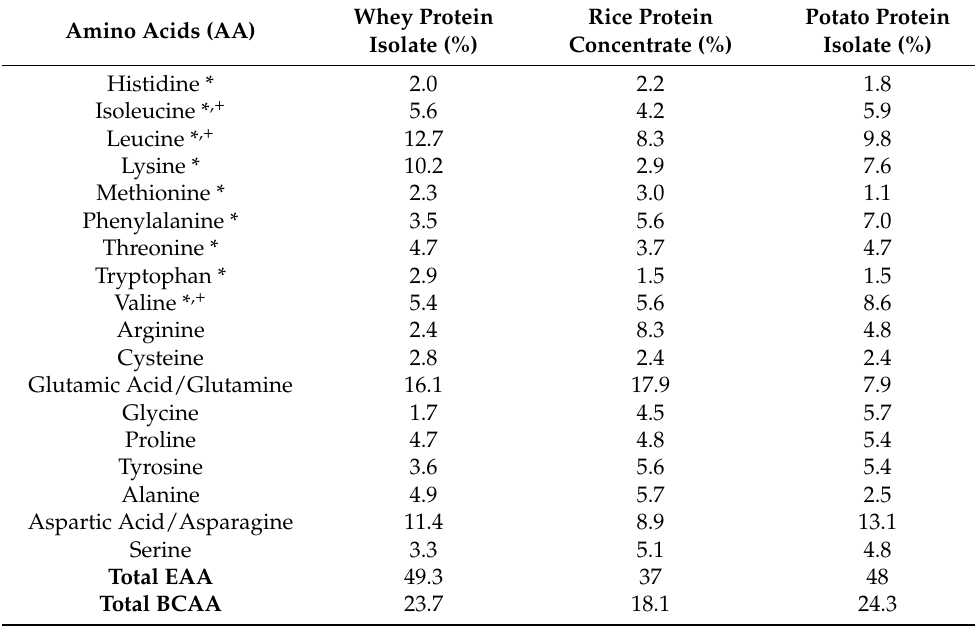
Table 2. Typical amino acid profile expressed per 100 g